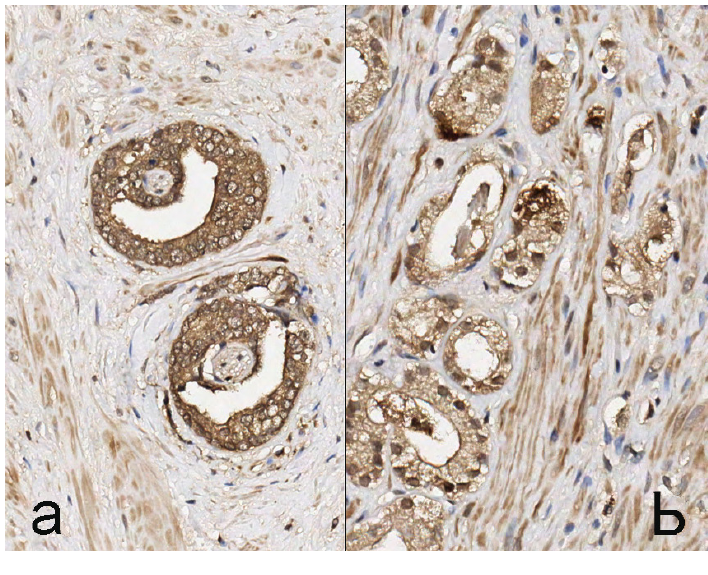
Figure 4. GRPR staining in prostate cancer tissue. ( a ) Strong brown cytoplasmic staining for GRPR in prostate cancer cells and weak background staining of prostate stromal cells; ( b ) equal staining intensity of prostate cancer and stroma, 200×